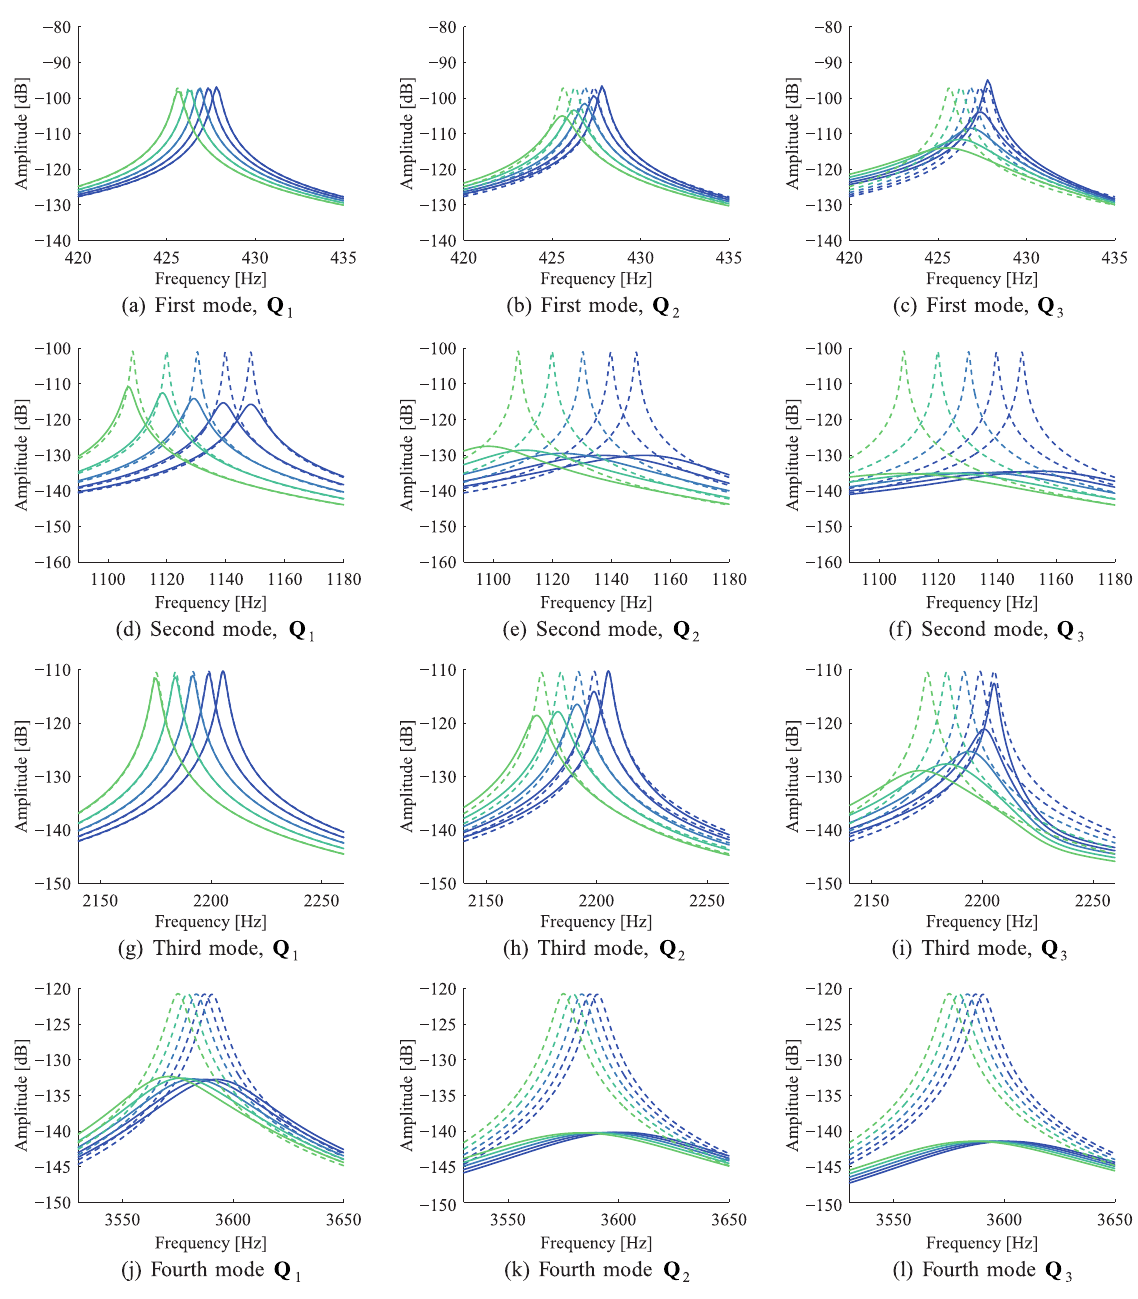
Fig. 7. Uncontrolled ( - - ) and controlled ( — ) FRF of the multi-cracked beam in the second case for the first fourth mode ( (cid:2) : μ = 0 , (cid:2) : μ = 1 / 16 , (cid:2) : μ = 1 / 8 , (cid:2) : μ = 3 / 16 , (cid:2) : μ = 1 / 4 ) for three ponderations Q 1 , Q 2 and Q 3 . between the state model used by the controller and the real structure. These changes modify the controller behaviour and induce some active damping on the first and third modes initially very slightly controlled and are here used as an indicator of cracks presence. These results can be physically interpreted. The stiffness of the cracked structure is lower than the uncracked ones. The piezoelectric components are therefore more efficient and the electromechanical coupling coefficient is increased. This variation is taken into account in the B s and C s matrices. Moreover,